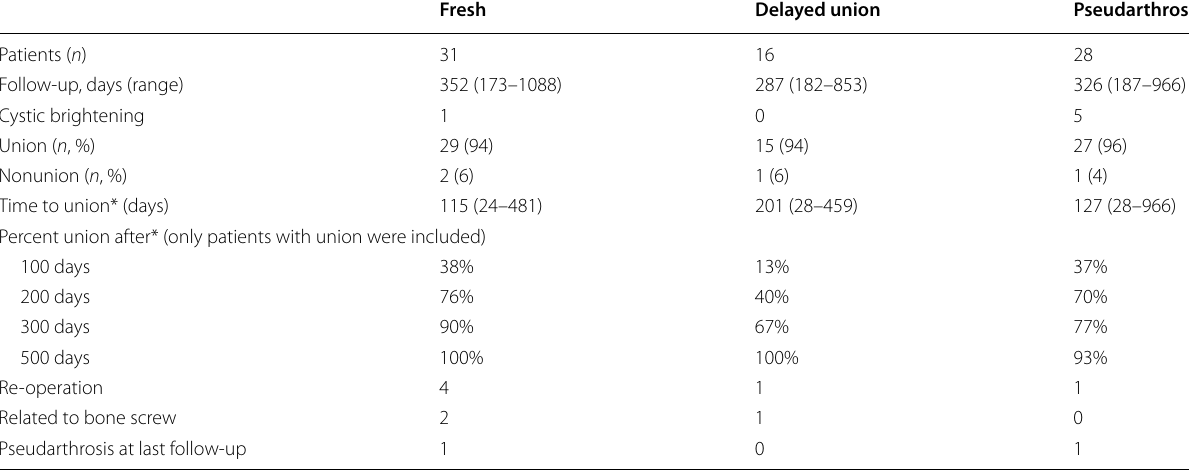
Table 3 Post-surgery